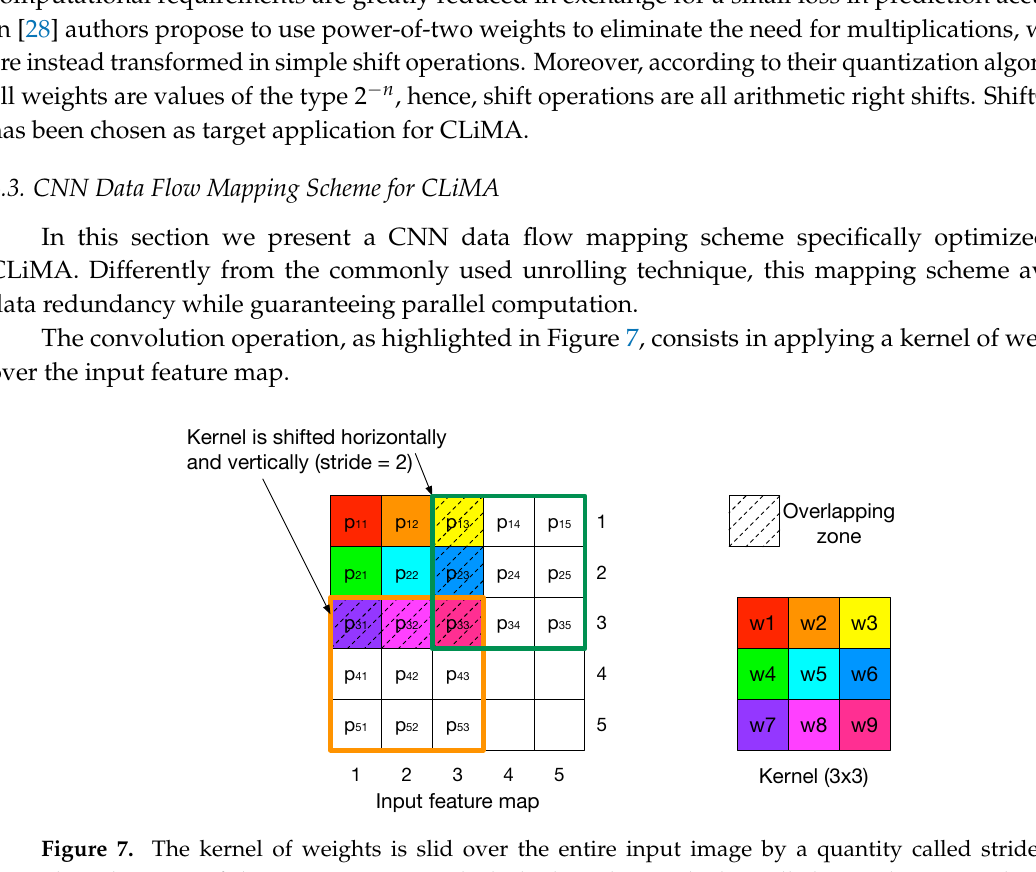
Figure 7. The kernel of weights is slid over the entire input image by a quantity called stride. The sub-region of the input image on which the kernel is applied is called convolution window. Convolution widows partially